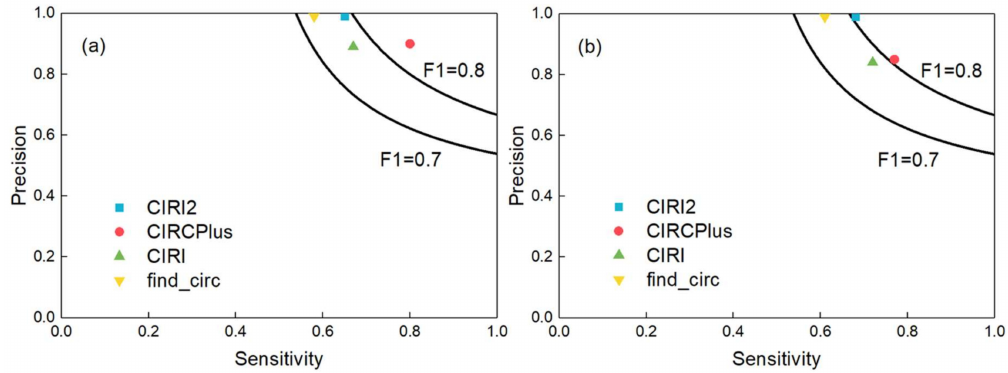
Figure 2. Comparisons of CIRCPlus and three popular circRNA detection methods. ( a ) Sensitivity and precision comparison among CIRCPlus and other methods, when the average read depth of linear transcripts was set to 10-fold (read length was set to 100 bp). ( b ) Sensitivity and precision comparison among CIRCPlus and other methods, when the average read depth of linear transcripts was set to 50-fold (read length was set to 100